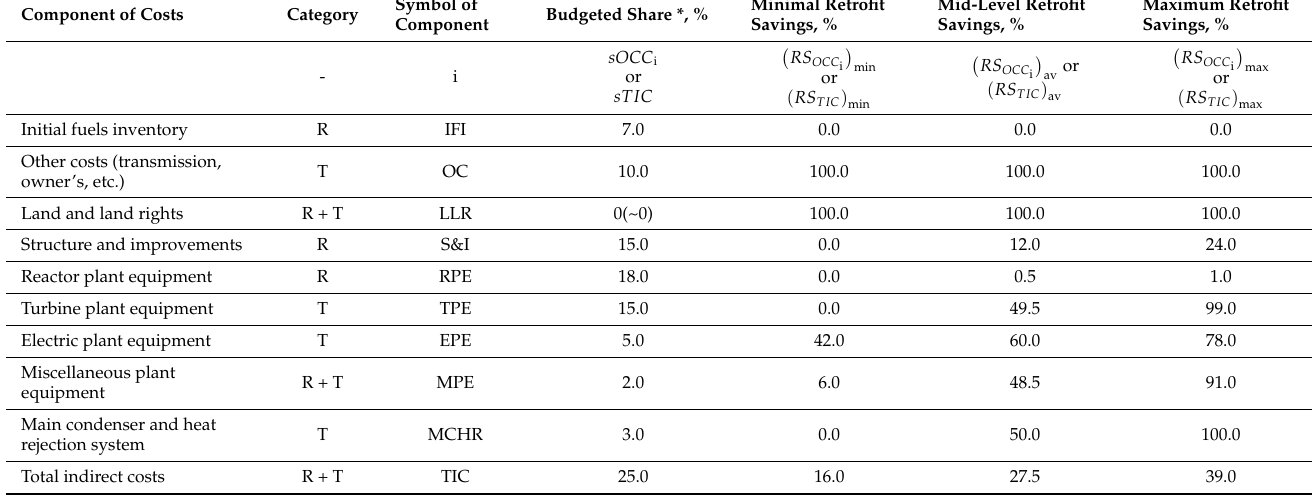
Table 5. Overall capital costs and total indirect costs for respective components of investment subject